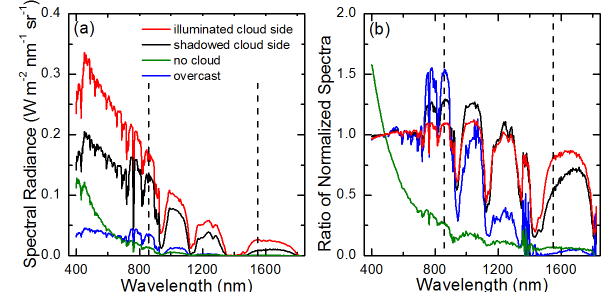
Fig. 7. (a) Spectra of different observing situations: illuminated cloud side, cloud shadow, overcast, and no cloud. (b) Normalized spectral ratios for the cloud scenes from (a) related to a spectrum of illuminated cloud side.